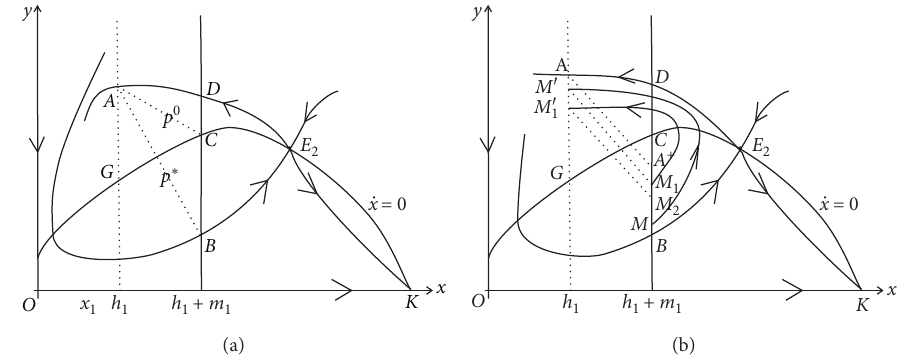
Figure 2: Existence of order-1 homoclinic cycle and order-1 periodic orbit of system (11).